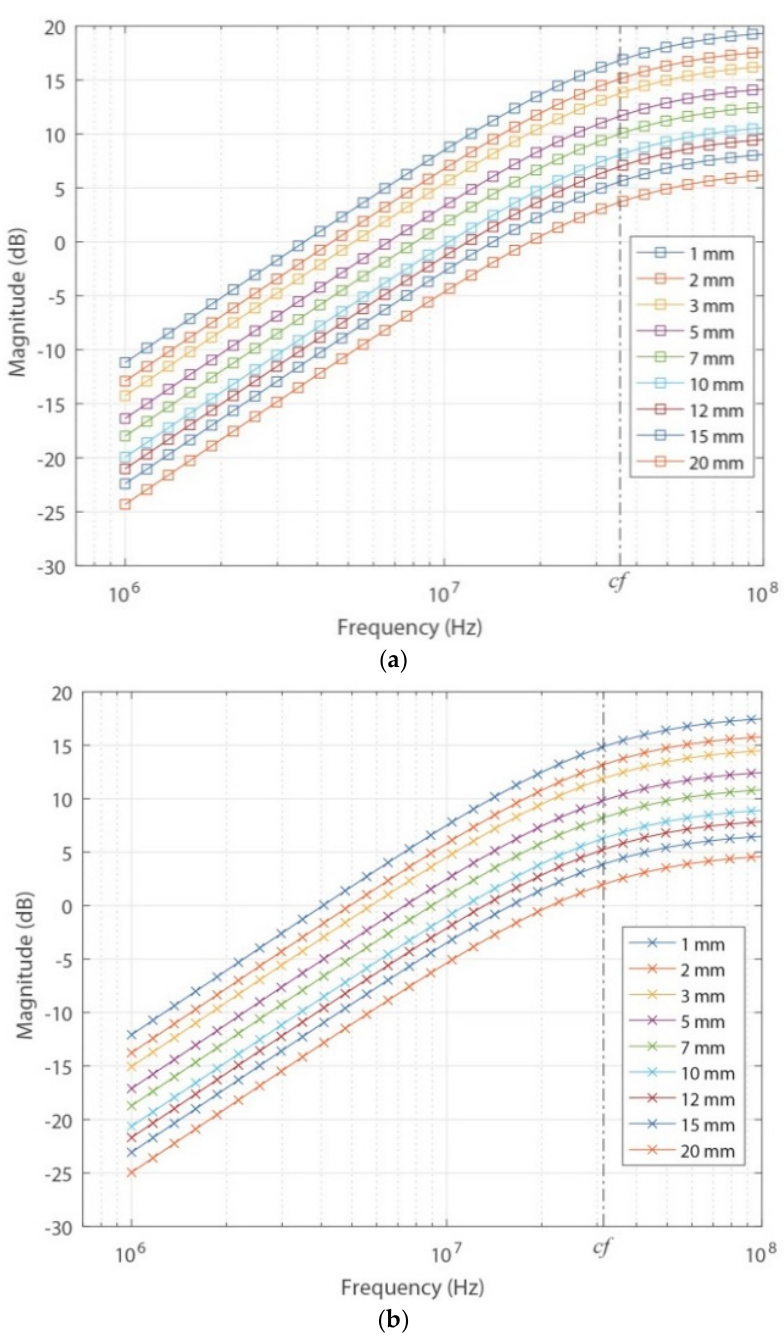
Figure 10. Frequency responses of the ILS for different values of a . ( a ) Theoretical; ( b ) by FEMM.